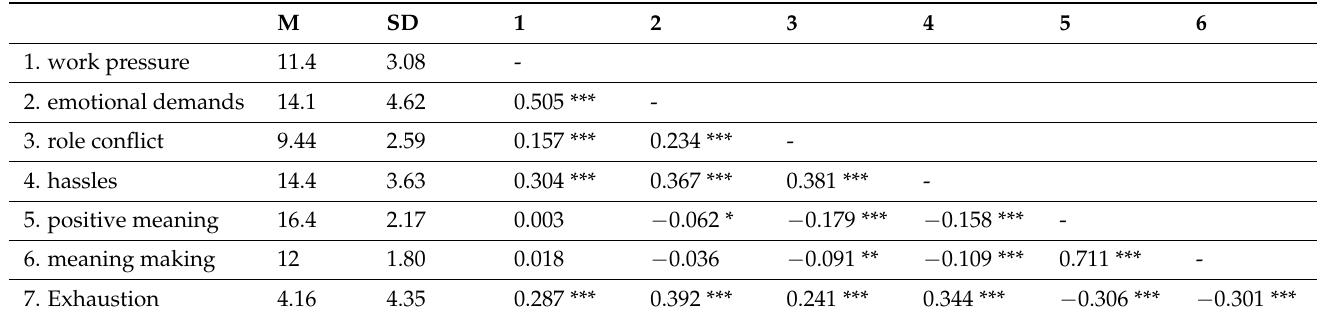
Table 1. Descriptive statistics and inter-correlations of the study variables.